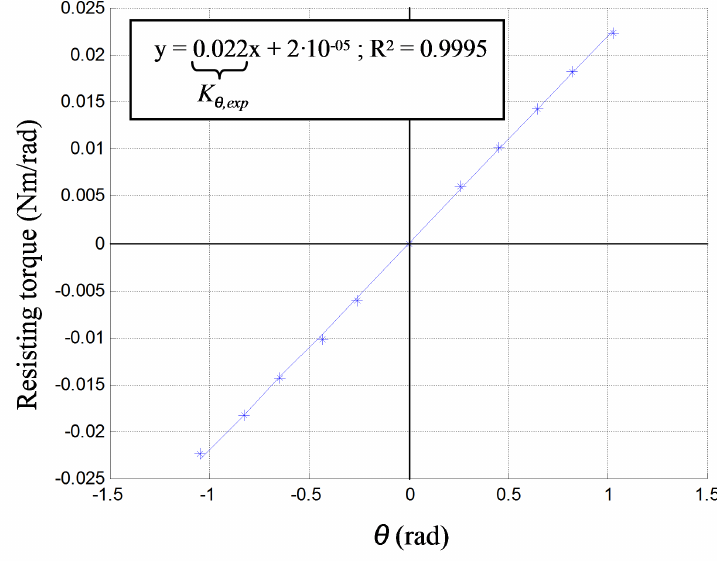
Figure 15. Experimental stiffness K